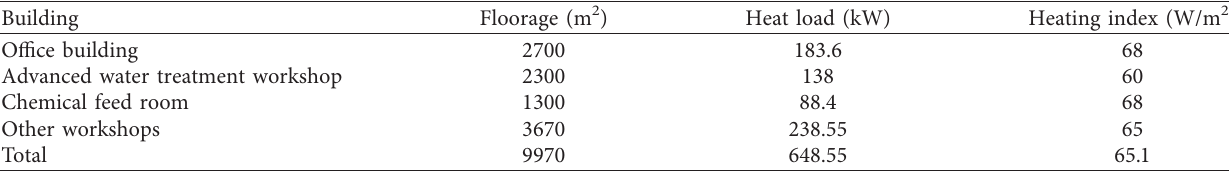
Table 1: Head load of buildings.